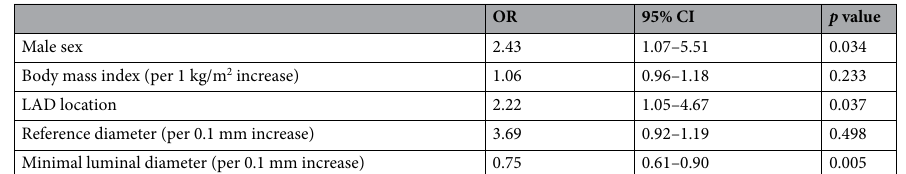
Table 5. Association with anatomical-functional reverse mismatch in multivariable analysis. CI indicates confidence interval, LAD left anterior descending coronary artery, OR odds ratio.